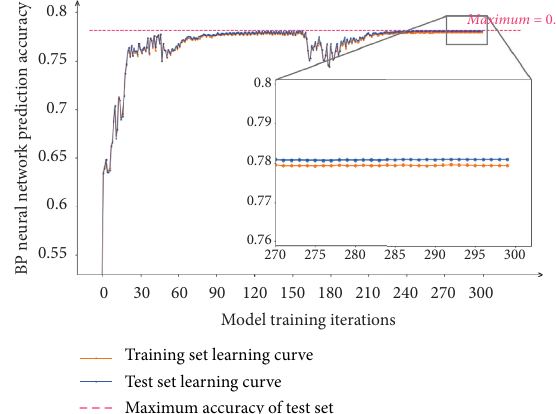
Figure 19: The learning curve of driving risk prediction